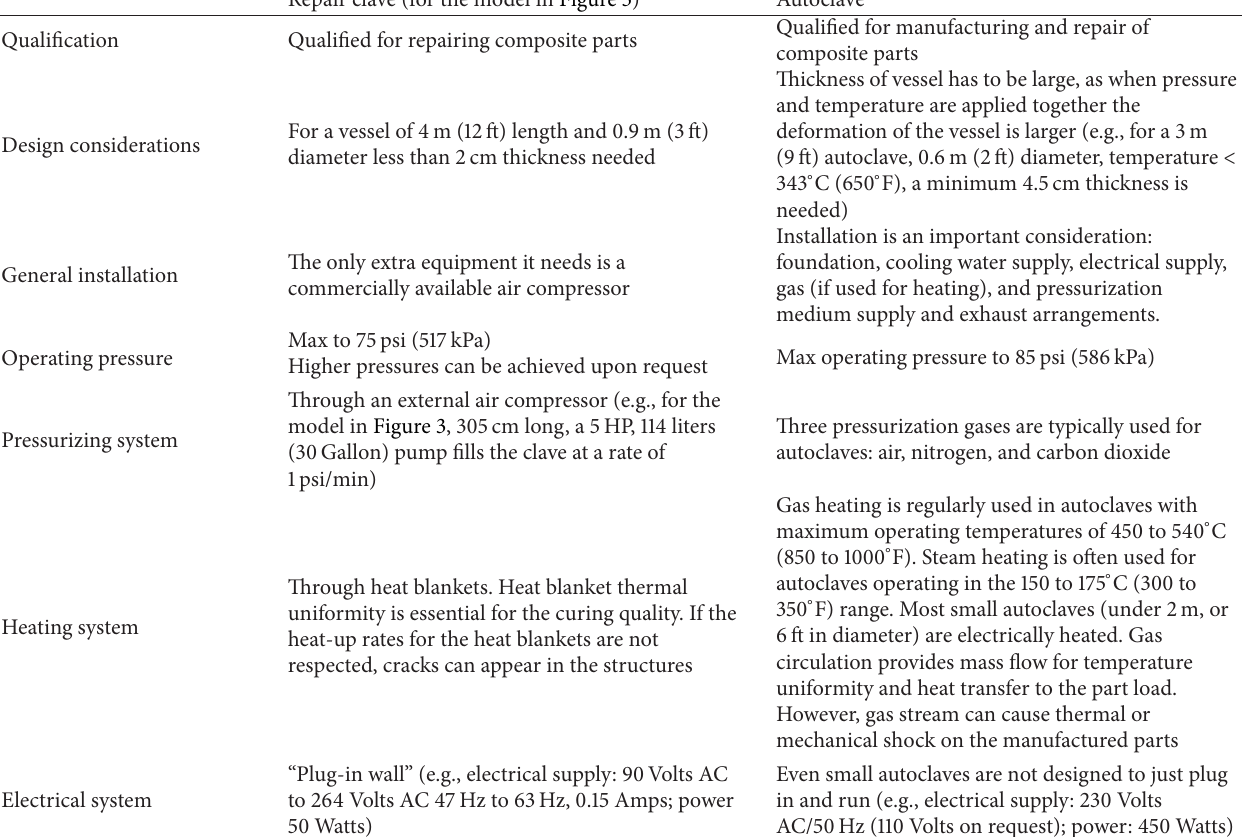
Table 1: Repair clave and autoclave advantages and disadvantages [14, 28, 29]. Repair clave (for the model in Figure